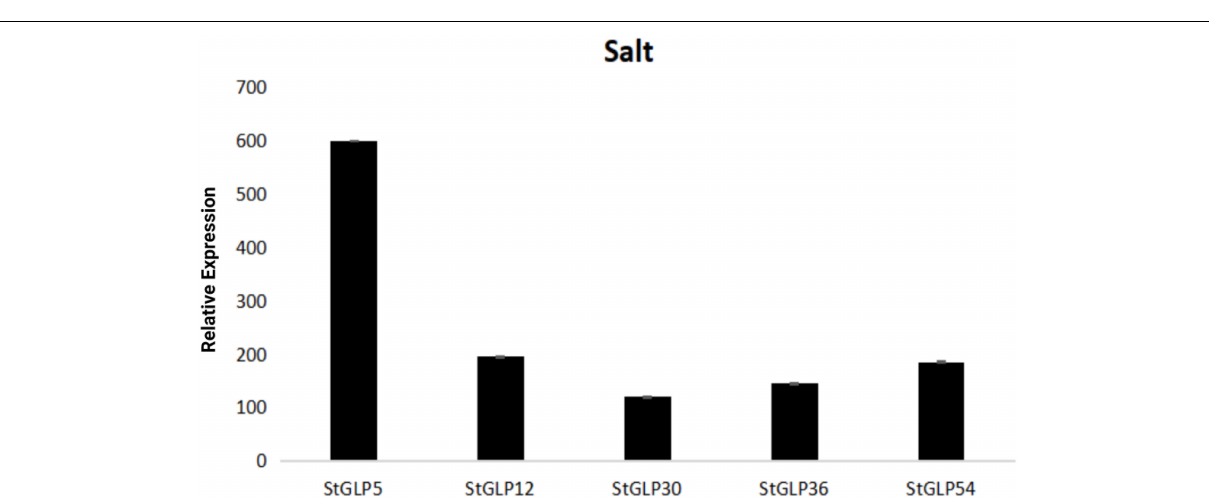
FIGURE 12 | Real-time relative expressions of StGLPs in salt